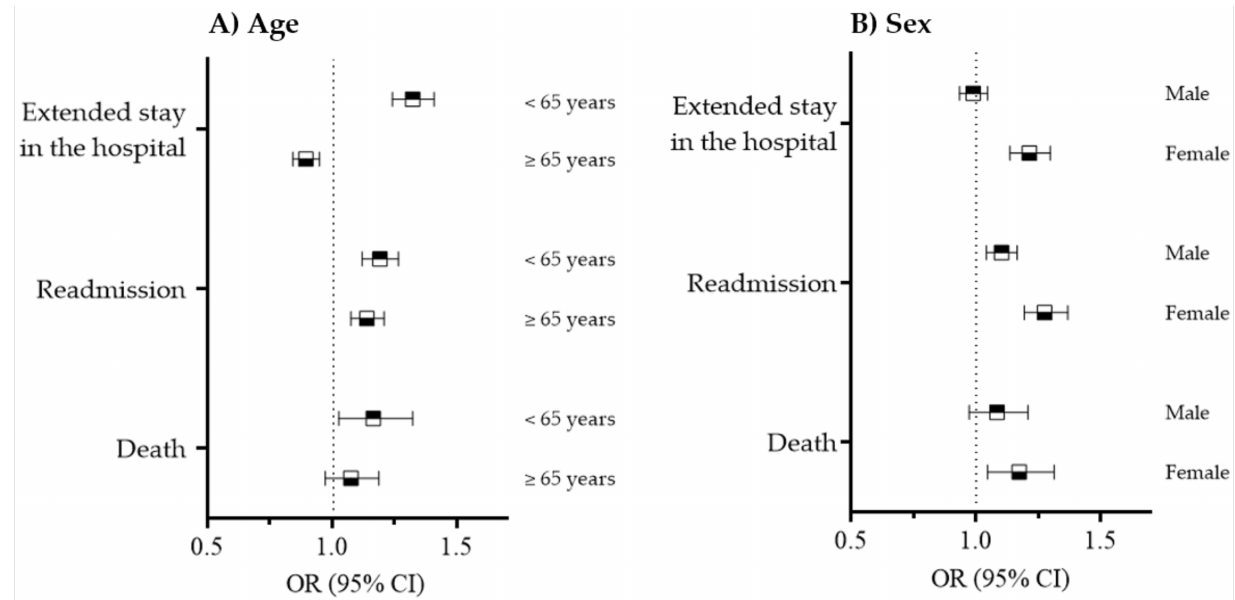
Figure 2. Health outcomes of stroke patients with a prehospital visit compared with patients without a prehospital visit according to age and